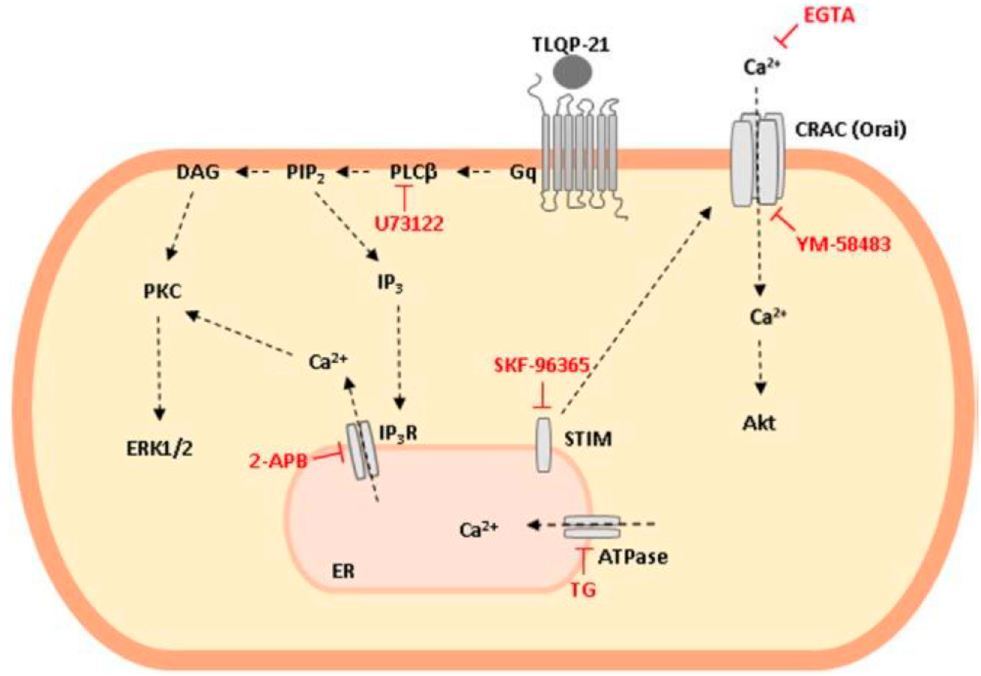
Figure 2. Schematic representation of TLQP-21 intracellular transduction mechanism in Chinese Hamster Ovary (CHO-K1) cells. TLQP-21, by binding a G protein coupled receptor (GPCR), activates Phospholipase C (PLC)- β that in turn produces Diacylglycerol (DAG) and Inositol Trisphosphate (IP3) as second messengers. These molecules activate Protein kinase C (PKC), stimulate extracellular signal-regulated kinase (ERK)1 / 2 phosphorylation and induce intracellular Ca 2 + release from the endoplasmic reticulum (ER) with the subsequent Ca 2 + entry from outside the cell, mediated by the stromal interaction molecules (STIM) and calcium release-activated calcium channel (CRAC)-Orai1 interaction. Phosphorylation of AKT is probably a result of the increase in cellular Ca 2 + concentrations.